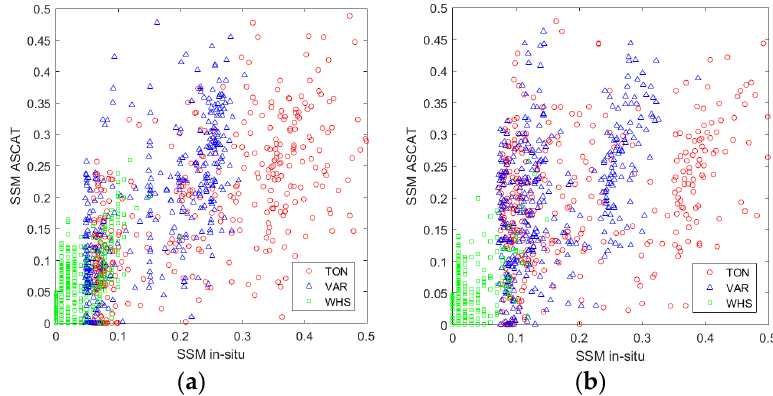
Figure 5. Scatter diagram of in situ and predicted SSM from ASCAT for all different land cover types in USA sites include US_TON, US_VAR and US_WHS ( a ) 2010 and ( b ) 2011.